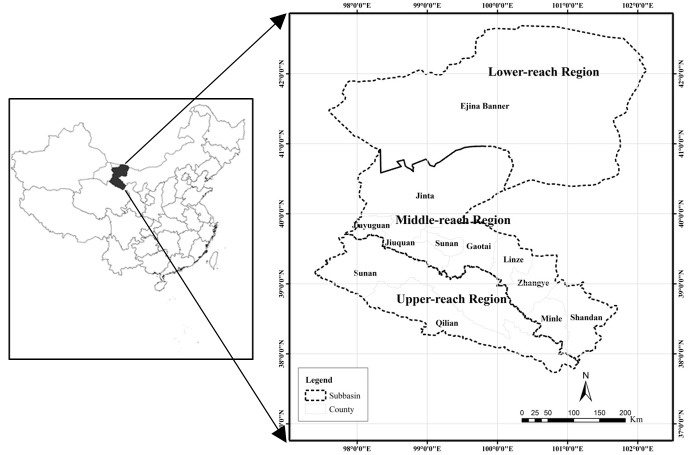
Heihe River Basin and its location in China.